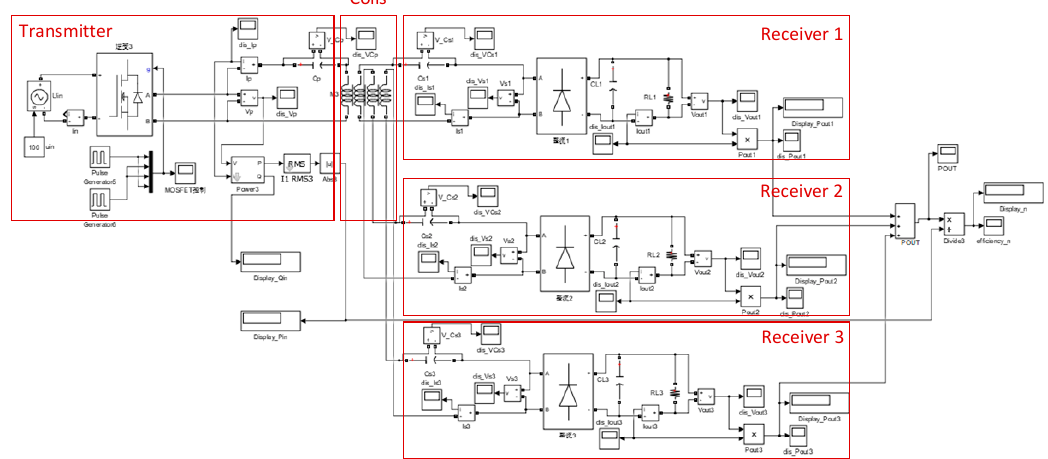
Figure 3. Circuit model of wireless charging system with three receivers in Simulink.